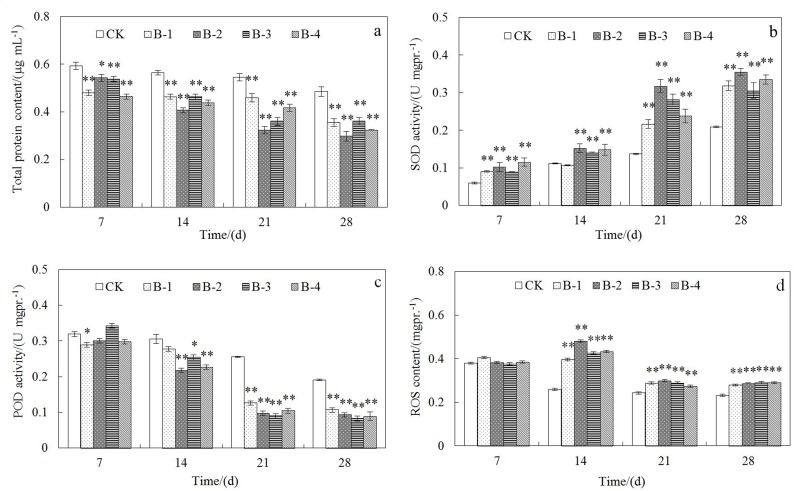
Toxicity effects of DnBP on biochemistry parameters of E. fetida.(a) Total protein content; (b) SOD activity; (c) POD activity; and (d) ROS activity were determined after treated for 7d, 14d, 21d and 28d in spiked natural soil CK, B-1, B-2, B-3, and B-4 (n = 4; error bars, SEM/mean values of standard errors). The spiked concentrations of DnBP were 0, 1, 2.5, 5, and 10 mg kg-1 soil. Asterisk shows significant difference at p<0.05 level compared to the control; double asterisks show significant difference at p<0.01 level compared to the control.